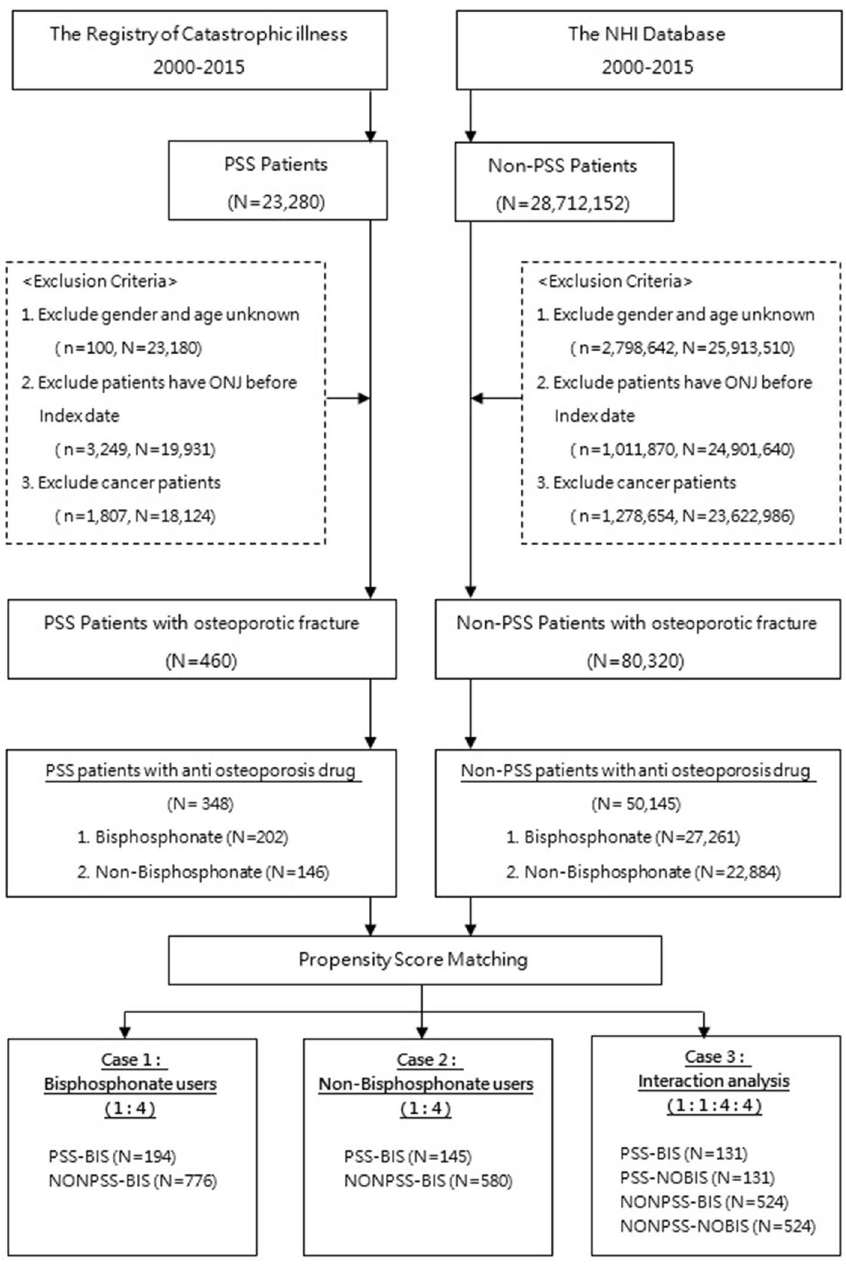
Figure 1. Flow chart of the study